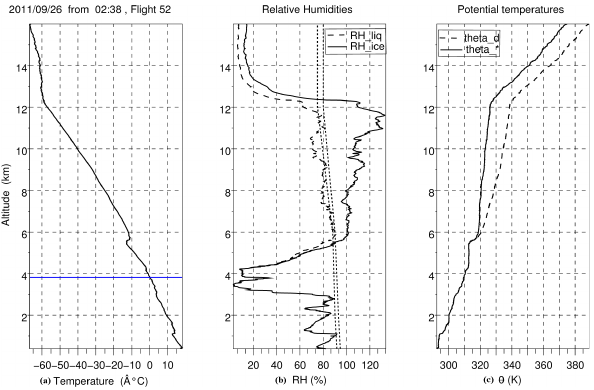
Fig. 1. (Left) Temperature profile for flight 52 (32nd flight used). The temperature T = 0 ◦ C underneath the altitude of 4.0km is em- phasized by the horizontal line. (Center) The corresponding profiles of relative humidity RH (%) over liquid water (solid line) and over ice (dashed line). The dotted lines show the Zhang et al. (2010) hu- midity thresholds. (Right) The corresponding profiles of potential temperature θ (dashed line) and of the composite potential temper- ature θ ∗ (solid) (see text for more